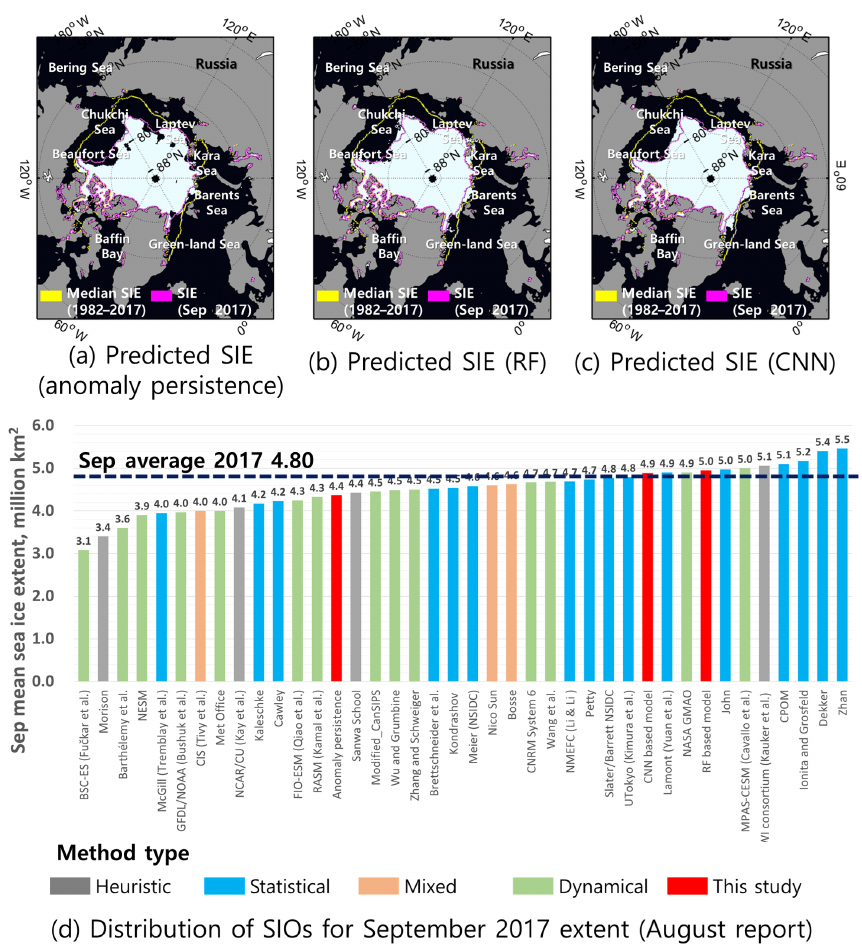
Figure 5. The predicted SIEs using the anomaly persistence (a) , RF (b) , and CNN (c) for September 2017. Distribution of SIO values for September 2017 SIEs reported in August 2017 (d)